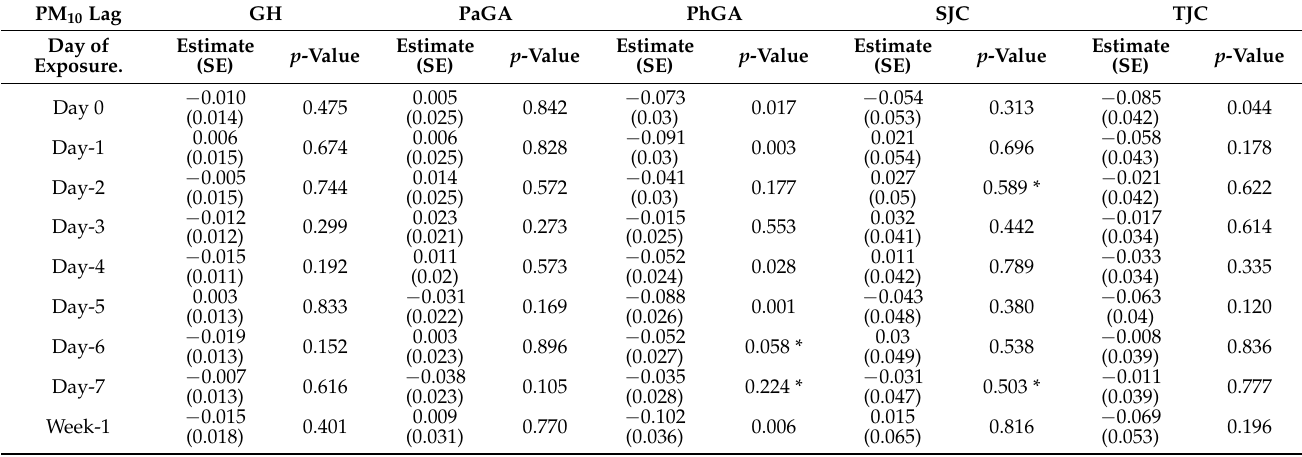
Table A6. Associations between PM 10 short-term exposure and RA disease